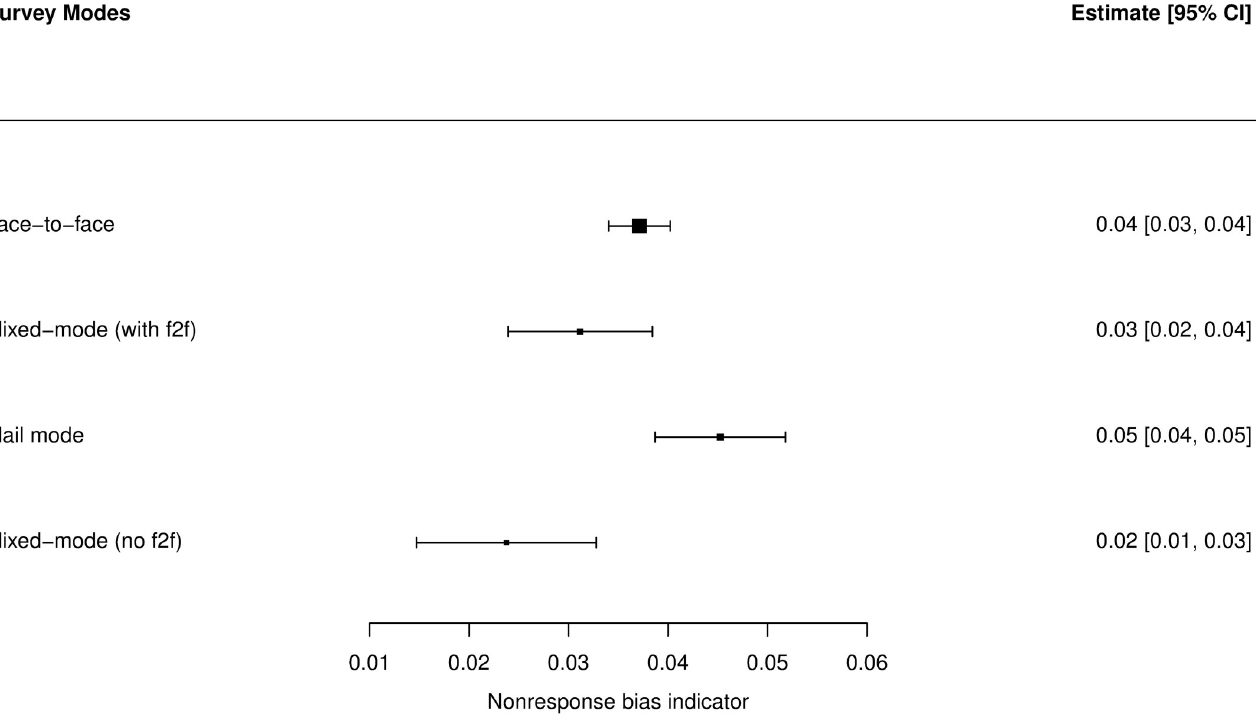
Fig 2. Distribution of NBI values of surveys in the dataset by survey modes—forest plot. N = 795.